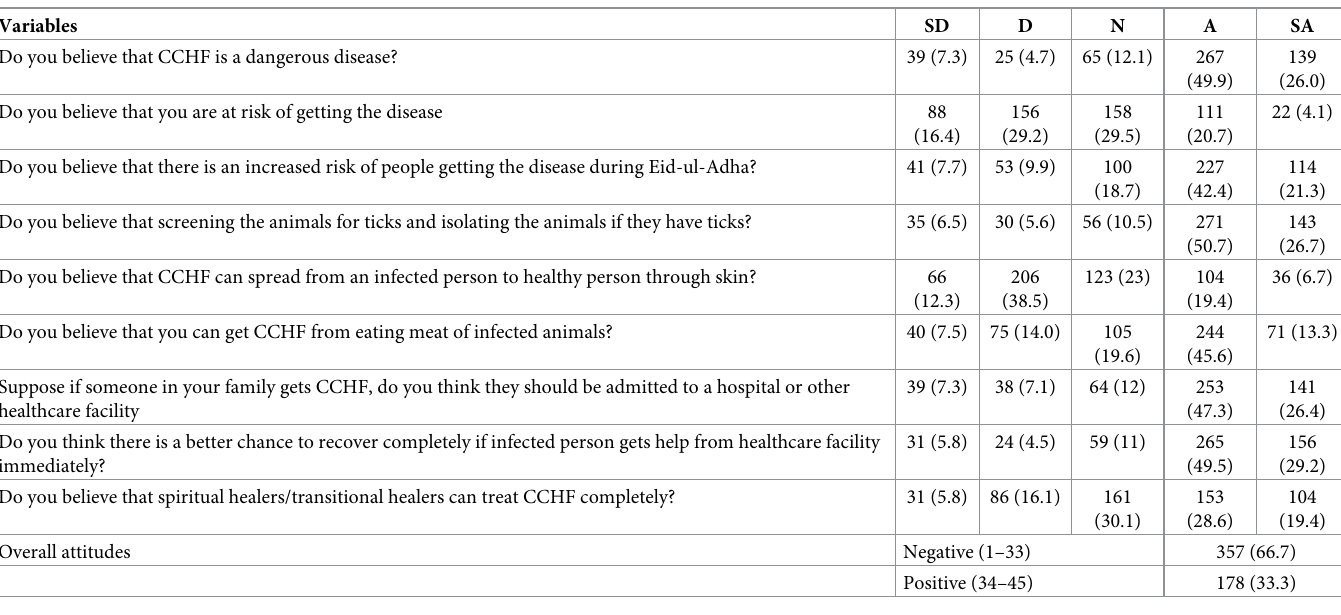
Table 4. Attitude among general people regarding Congo ( N = 535).